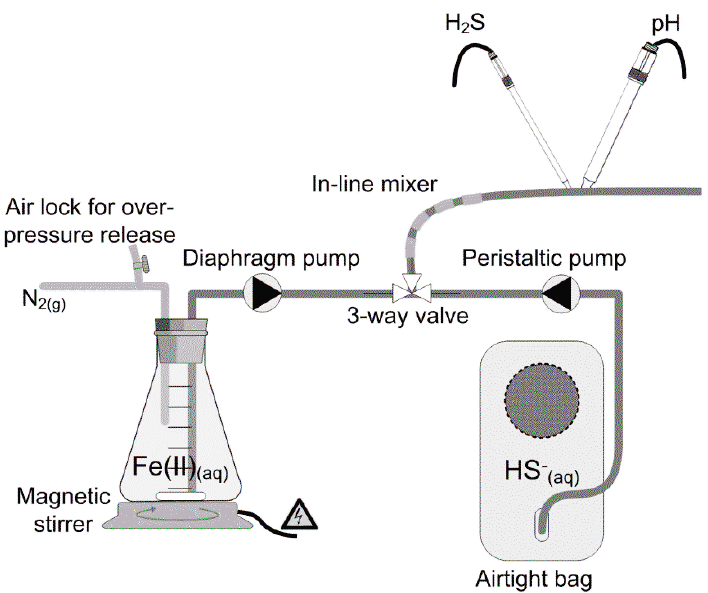
Figure 1. Experimental setup for measurement of sulfide precipitation with ferrous iron. Sulfide and iron solutions were pumped in separate lines to a mixing point and injected to the reaction tubing where sulfide and pH were measured online. The reaction time of the precipitation reaction was altered by varying the length of the reaction tube.